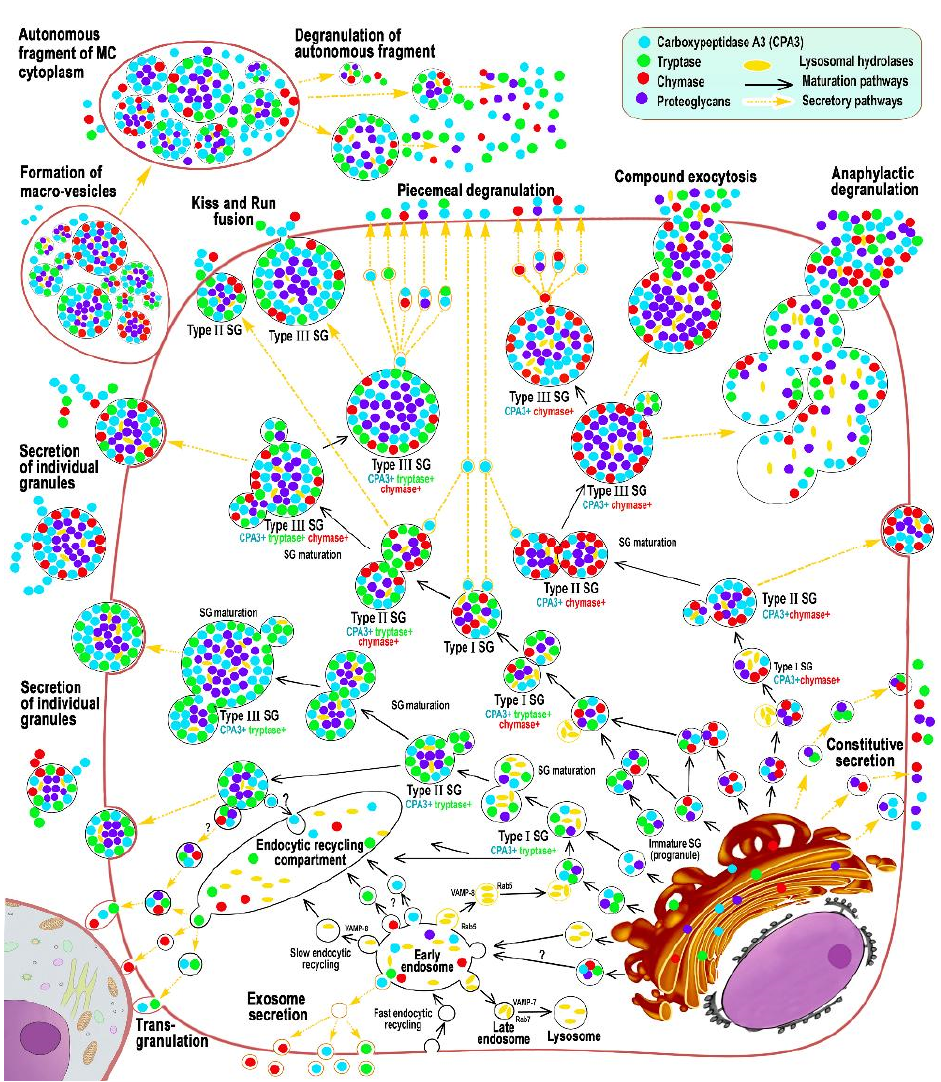
Figure 1. Main stages of biogenesis and secretory pathways of mast cell carboxypeptidase A3 (adapted from Atiakshin [84]). The diagram shows the main stages of post-translational modification of CPA3 with an emphasis on cytotopography, intragranular localization, and secretory mechanisms. CPA3 biosynthesis begins in the granular endoplasmic reticulum mast cells (MC) and continues in the Golgi apparatus (GA), where the progranule is formed. Secretory granules (SG) can be classified into 3 types. Type I SGs are formed after fusion of lysosomes with progranules, budding from GA,and have the smallest size and initial CPA3 content. The size of type I granules can increase due to homotypic fusion with the formation of type II granules with a size of 0.2–0.4 µ m. Type II secretory granules already possess a certain phenotype of specific proteases. As a result of the completion of maturation, type III SGs are formed with a size of 0.5 µ m and more, which are characterized by the largest volume of secretome and peripheral localization of CPA3 in the form of a ring. The main mechanisms of CPA3 secretion from MC into the extracellular matrix are piecemeal degranulation, transgranulation, «kiss-and-run», exosome formation, exocytosis of individual secretory granules, as well as the formation of macrovesicles that retain the ability for autonomous secretion of proteases in a specific tissue